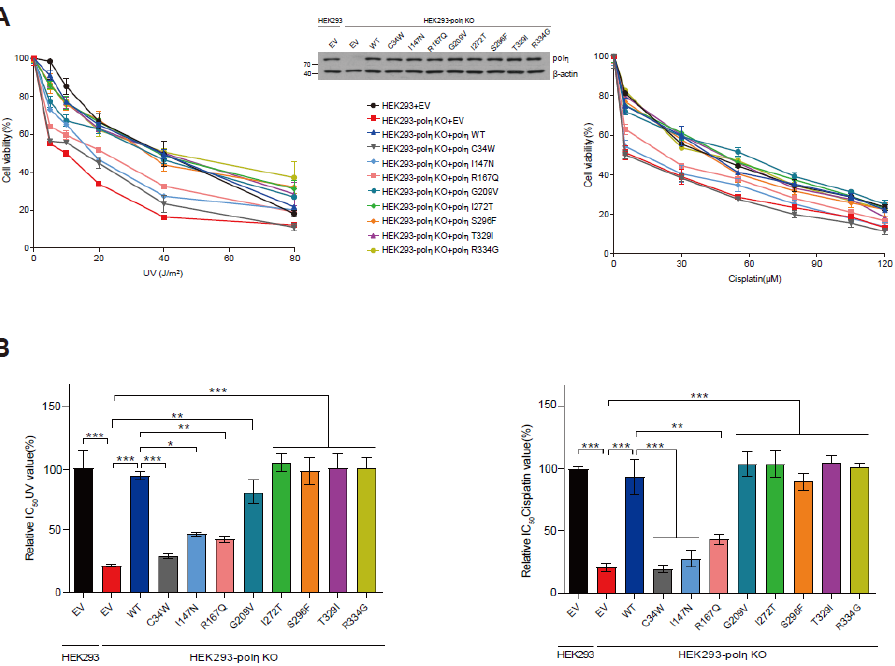
Figure 4. Effects of eight POLH variants on UV and cisplatin sensitivity in POLH-KO cells. ( A ) Abilities of eight pol η variants to rescue UV (left panel) and cisplatin (right panel) sensitivity in POLH-KO cells. Wild-type and POLH-KO cells transfected with indicated vectors were treated with UV radiation (0, 5, 10, 20, 40, and 80 J/m 2 ) or cisplatin (0, 5, 30, 55, 80, 105, and 120 μ M), and cell viability was determined. Middle panel: Representative immunoblots of cell lysates (20 µ g) from wild-type and POLH-KO cells transfected with the indicated vectors. ( B ) Relative IC 50 UV (left panel) and IC 50 cisplatin (right panel) values for wild-type cells and POLH-KO cells expressing wild-type or variants. IC 50 values calculated from Figure 4A were normalized to wild-type cells. Data are shown as means ± SEM from three independent experiments. * p < 0.05, ** p < 0.01, *** p < 0.001 (ANOVA with Tukey’s